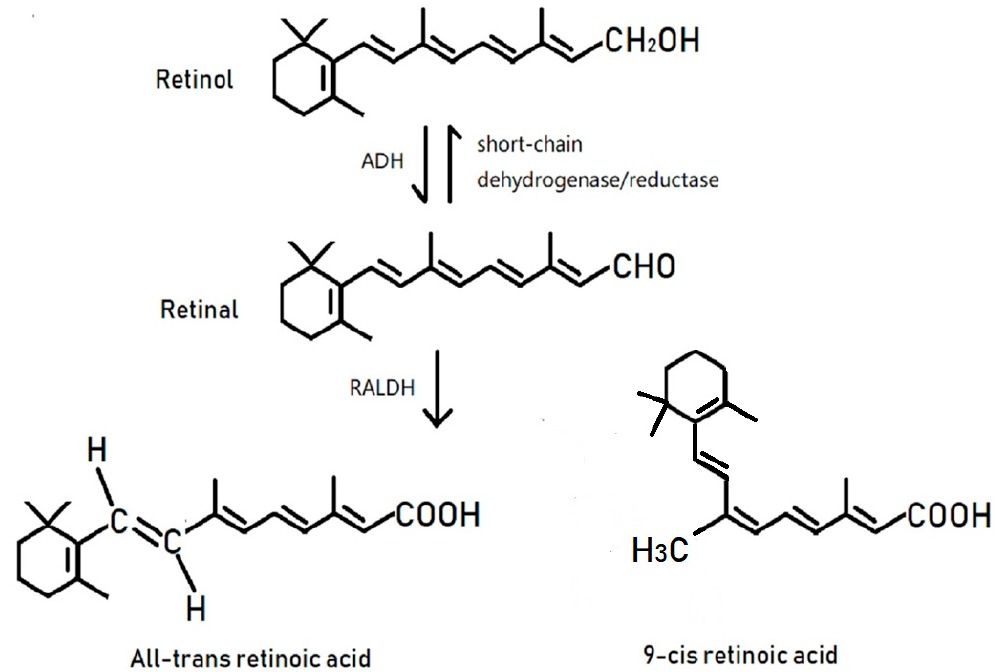
Figure 1. Transformation of retinol into bioactive retinoic acid involves a two-step oxidative reaction. To do this, a group of enzymes, divided in three families, will act together to form the final compound retinoic acid (RA). Retinol transforms into retinal under the catalytic action of the alcohol dehydrogenase (ADH) family; this step can also be regulated by the short-chain dehydrogenase/reductase family, which shows a wide affinity for alcohols and aldehydes. The aldehyde dehydrogenase (RALDH) family then catalyzes retinal to form retinoic acid. Both of the oxidation reactions transmit electrons through the electron acceptor NAD or NADP.